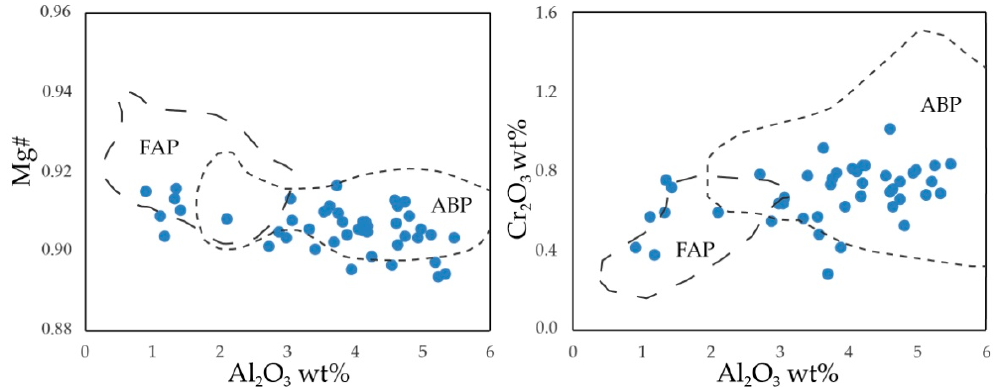
Figure 13. The composition of orthopyroxene: ABP—abyssal peridotites, FAP—fore-arc peridotites (after [67]).